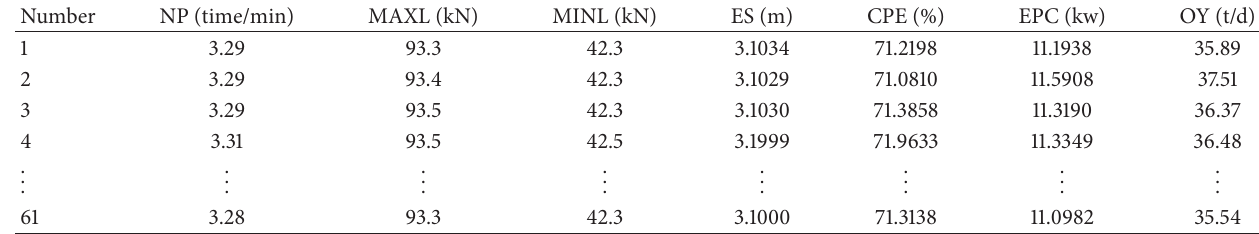
Table 5: Instances of solutions of Pareto optimal